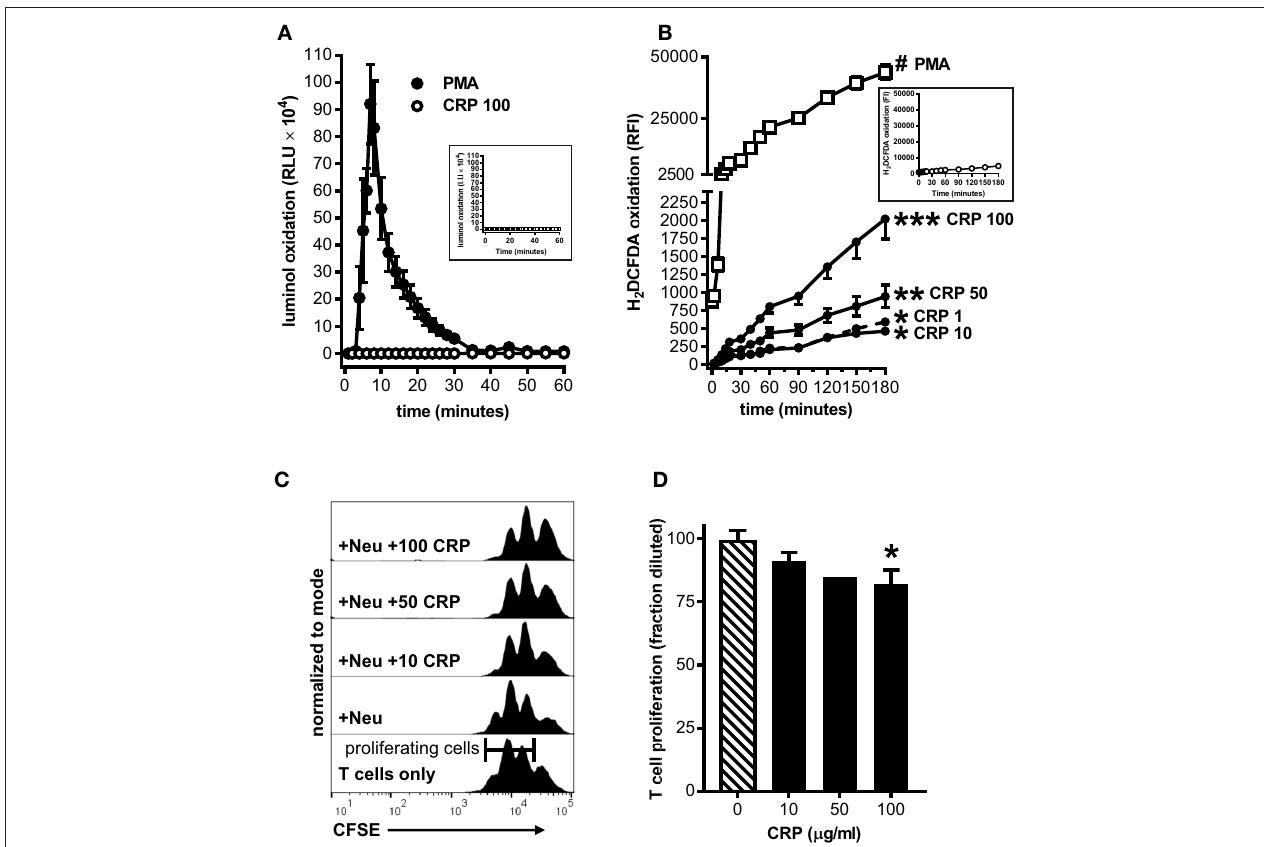
FIGURE 5 | Human CRP triggers iROS production by human peripheral blood neutrophils and grants them the capacity to suppress the proliferation of autologous T cells. Peripheral blood neutrophils were isolated from five healthy human donors (see the Materials and Methods ) to assess CRP’s impact on their production of iROS and suppression of T cell proliferation. (A) ROS generated by human neutrophils stimulated with PMA (100nM) vs. human CRP (100 µ g/ml) was measured by luminol assay. Similar to mouse MDSCs (see Figure 2A ), PMA stimulated human neutrophils showed a strong respiratory burst and those stimulated with CRP did not. Untreated controls are shown in the inset. (B) Intracellular ROS generated by human neutrophils stimulated with PMA (100nM) vs. human CRP (1–100 µ g/ml) was measured with the cell-permeant redox-sensing fluorescent dye H 2 DCFDA. Similar to mouse MDSCs (see Figure 2B ), human neutrophils exhibited a significant increase in iROS-dependent fluorescence intensity when stimulated with 100nM PMA or high concentrations of human CRP. The data shown are the mean ± SEM for two donors each done in triplicate and the asterisks indicate significantly higher RFI than untreated controls (shown in the inset) by Sidak’s multiple comparisons tests; * p < 0.05 at 60min, ** p < 0.05 at 30min, and *** p < 0.05 at 14min for CRP, and # p < 0.05 at 12min for PMA. (C) Representative CFSE dilution histograms (normalized to mode) for autologous human CD3 + T cells stimulated with anti-CD3 and anti-CD28 mAbs. From bottom to top the T cells received no further treatment, neutrophils (Neu at 1E:1T), or Neu plus 10–100 µ g/ml human CRP. The addition of CRP bestowed suppressive capacity to the autologous neutrophils in a dose-dependent fashion, as indicated by the rightward shift in the CFSE histograms. (D) CD4 + T cell proliferation in the presence of Neu performed as in (C) . The data shown are mean + SEM pooled across donors and are normalized to CD3/CD28 stimulated T cells in the presence of Neu with no CRP added (cross-hatched bar). The asterisk indicates significantly more suppression of T cell proliferation ( p < 0.05 for Sidak’s test) in the presence of CRP than in its